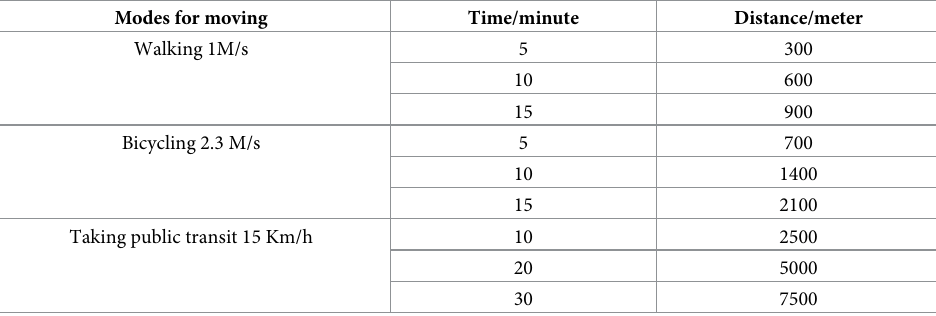
Table 2. Time and distance corresponding to different modes for moving.